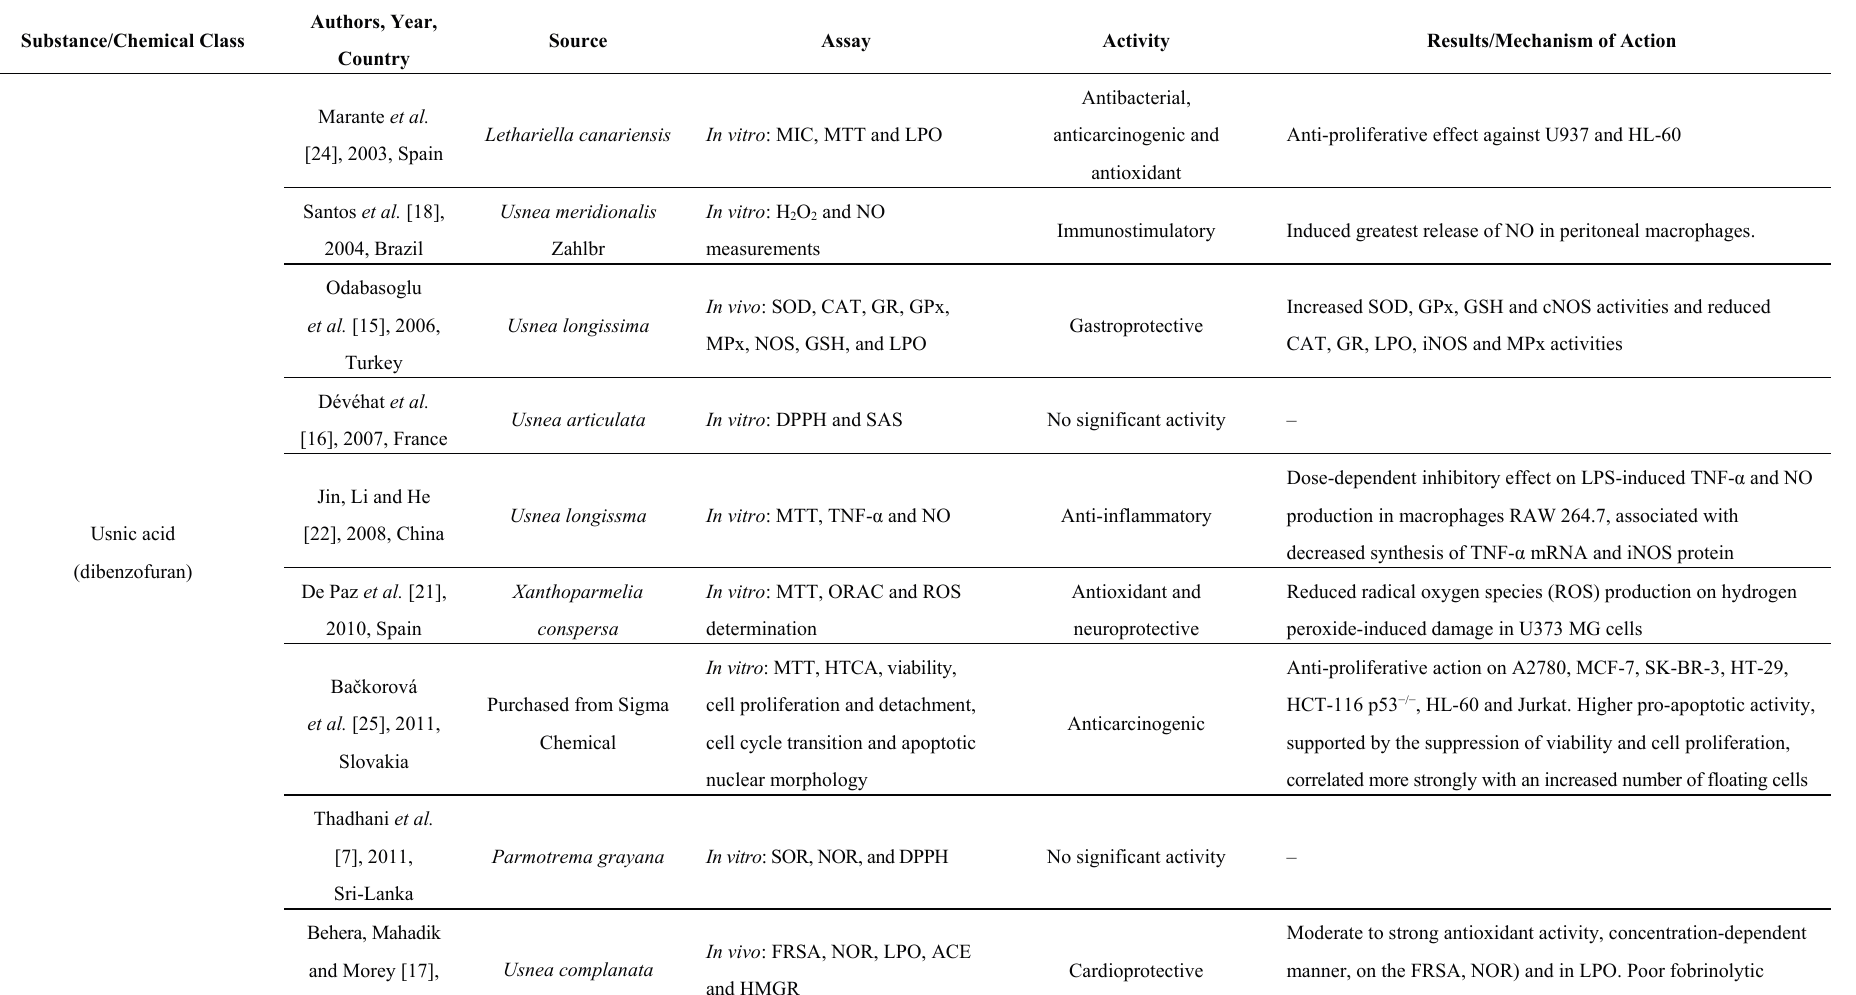
Table 1. Characteristics of Included